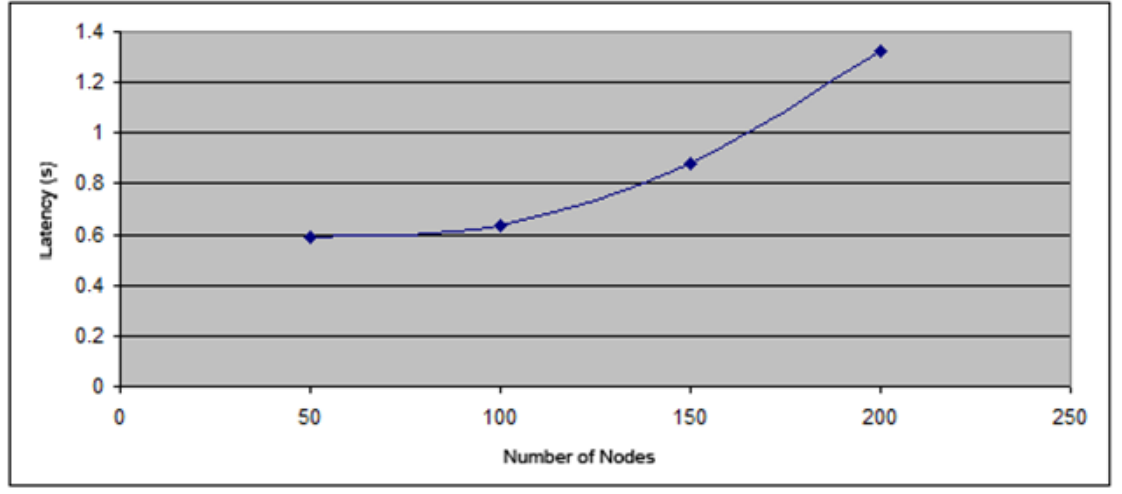
Figure 11. Latency in the IPv4 address assignment of a network from Class C.